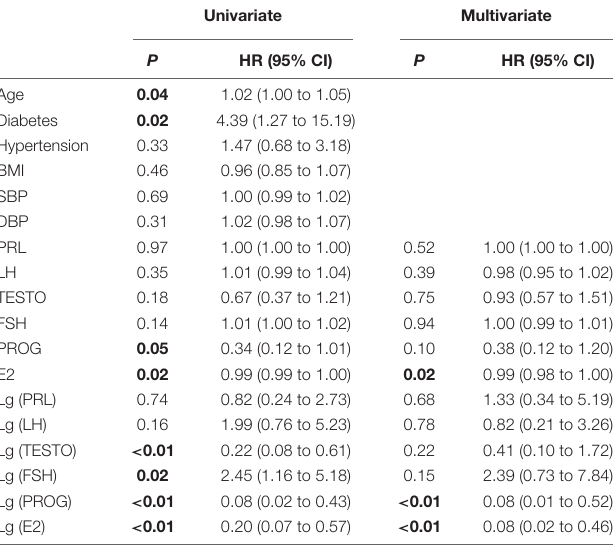
TABLE 5 | Univariate Cox proportional hazards regression analysis and multivariate Cox proportional hazards regression analysis to assess the value of baseline parameters associated with progression of